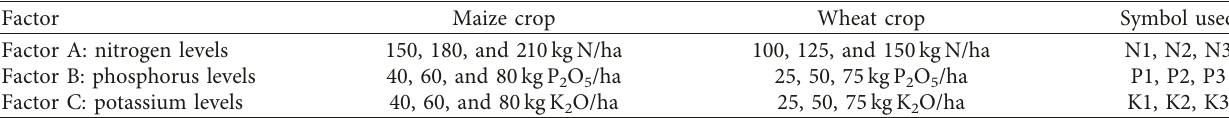
Table 2: Treatment details of the field experiment at Khumaltar, Lalitpur, Nepal, 2019/20–2020/21. Factor Maize crop Wheat crop Symbol